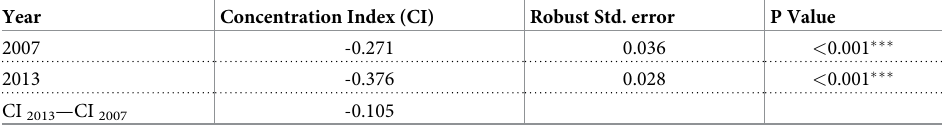
Table 2. Concentration indices for catastrophic health expenditure, 2007 and